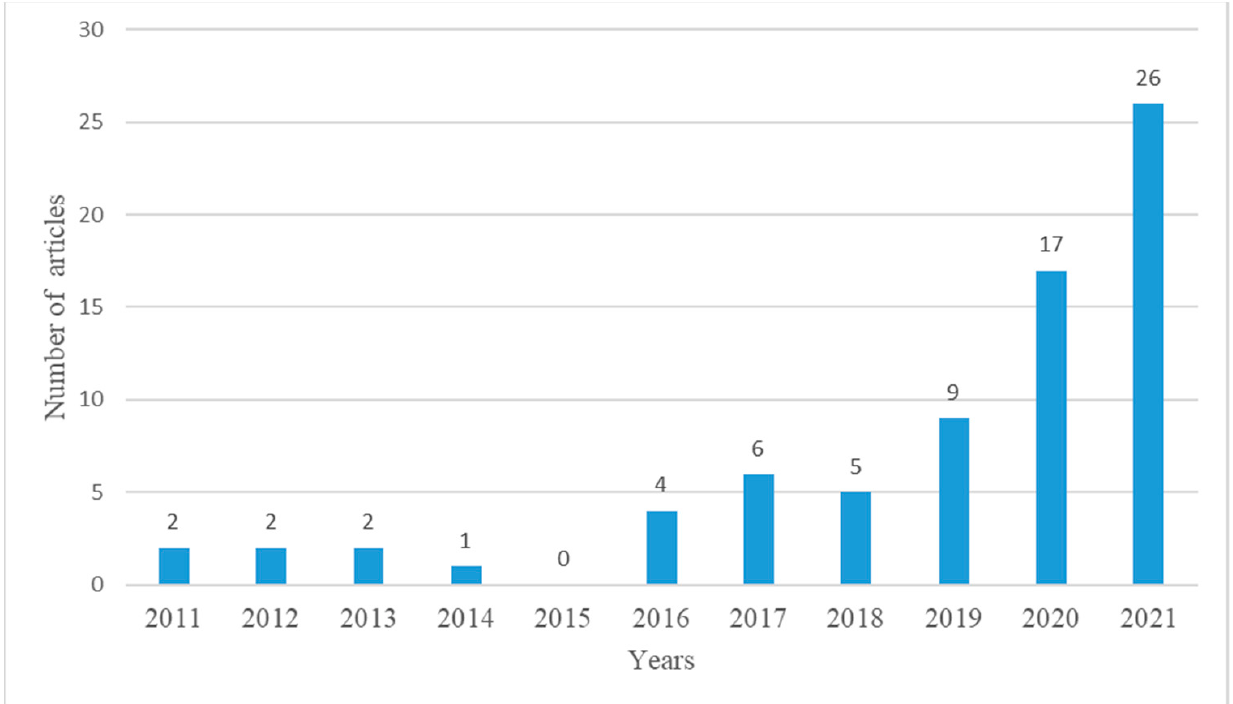
Figure 1. Journal articles on I4.0 and LSS integration per year